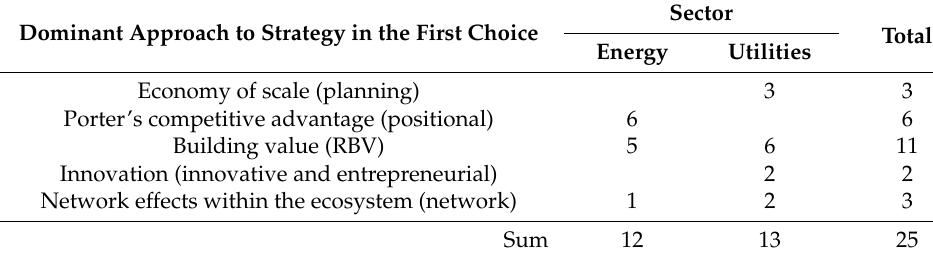
Table 6. Dominant approach to the companies’ strategy in the first